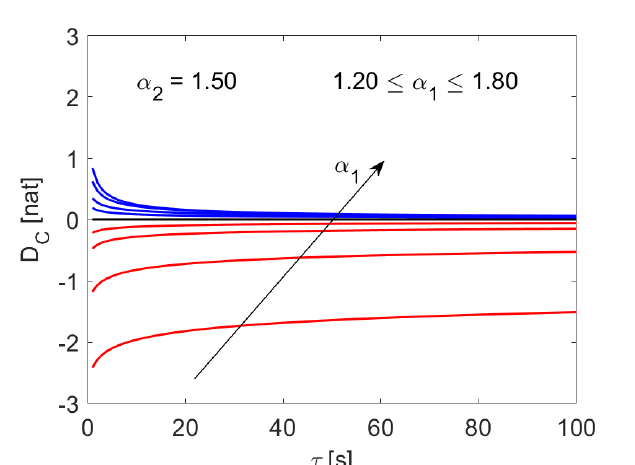
[ P || Q ] , defined by Eq. (11), vs. the cluster dura- Figure 5: Plot of the quantity D C tion τ . Blue curves correspond to a power law probability distribution P ( τ ) with α ranging between 1.55 ÷ 1.80. The model probability distribution Q ( τ ) is a power law = 1.50, the same for all the curves plotted here. Red with correlation exponent α 2 curves correspond to a power law probability distribution with α 1.20 ÷ 1.45. The black line corresponds to the null hypothesis D = 1.50 and α = with α 1 2